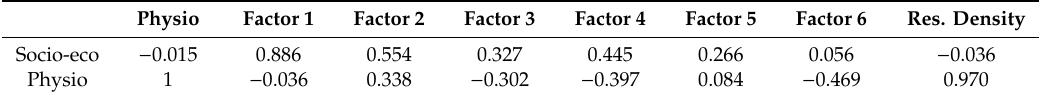
Table 5. Spearman coe ffi cient between vulnerabilities, components and residential density (inhab. / km 2 ).